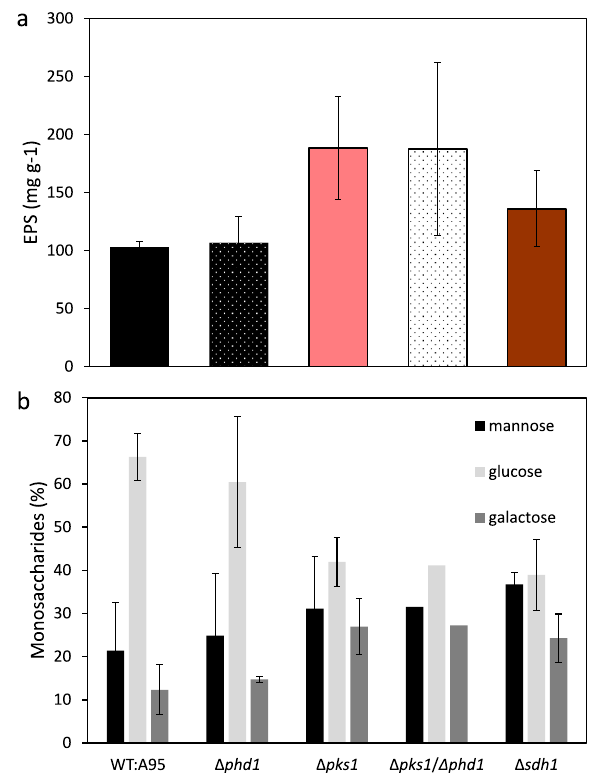
Fig. 2 EPS amounts and monosaccharide compositions of bio fi lms of K. petricola WT and pigment mutants. Shown are the averages together with two times the standard error of the biological replicates (except for the monosaccharide composition of Δ pks1 / Δ phd1 , for which one biological replicate was analysed and no uncertainty is given). The WT data have already been published 15 and are shown here again for comparison with the mutant strains. a The amounts of EPS produced by K. petricola WT and Δ phd1 are lower than the EPS amounts produced by the Δ pks1 and Δ pks1 / Δ phd1 mutant strains. b The monosaccharide compositions of K. petricola WT and Δ phd1 are different from the composition of the other pigment mutant strains.